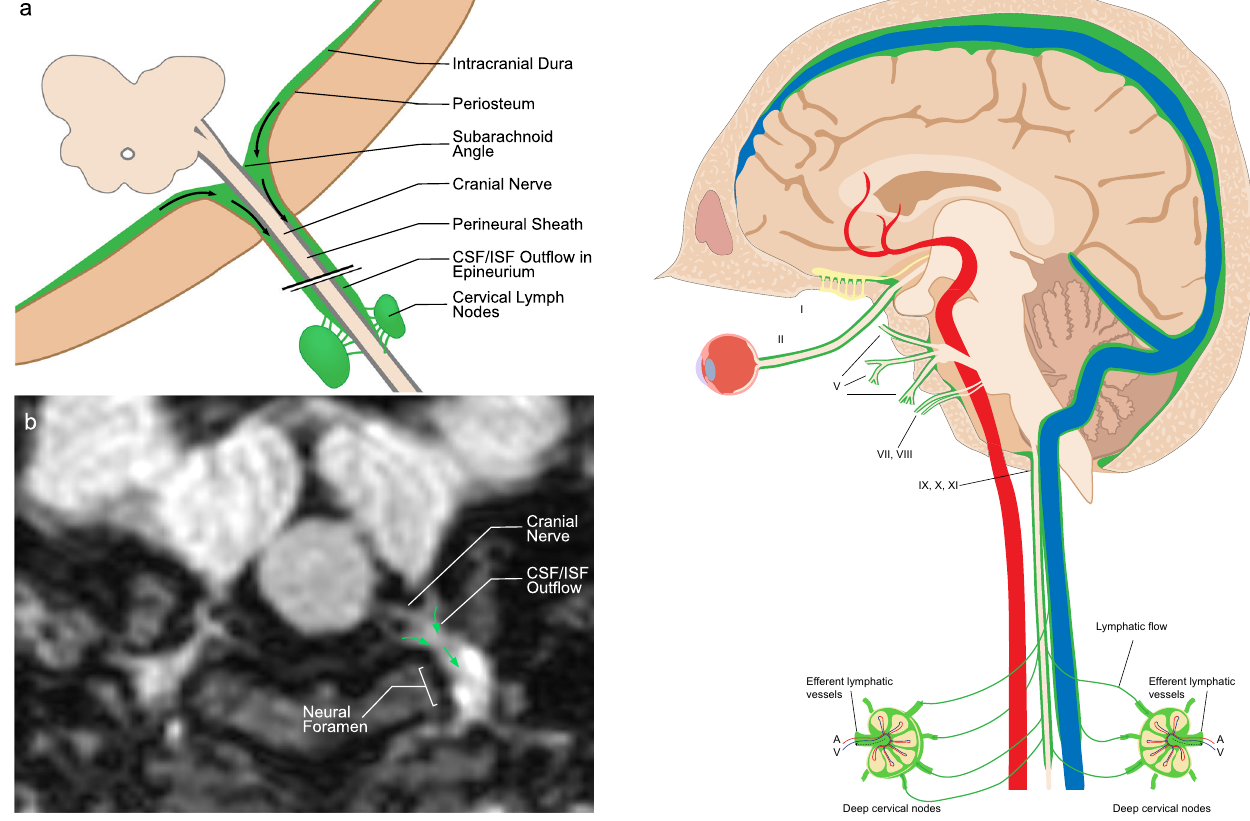
and vascular) decreased with age as well. Atrophy of these LNs